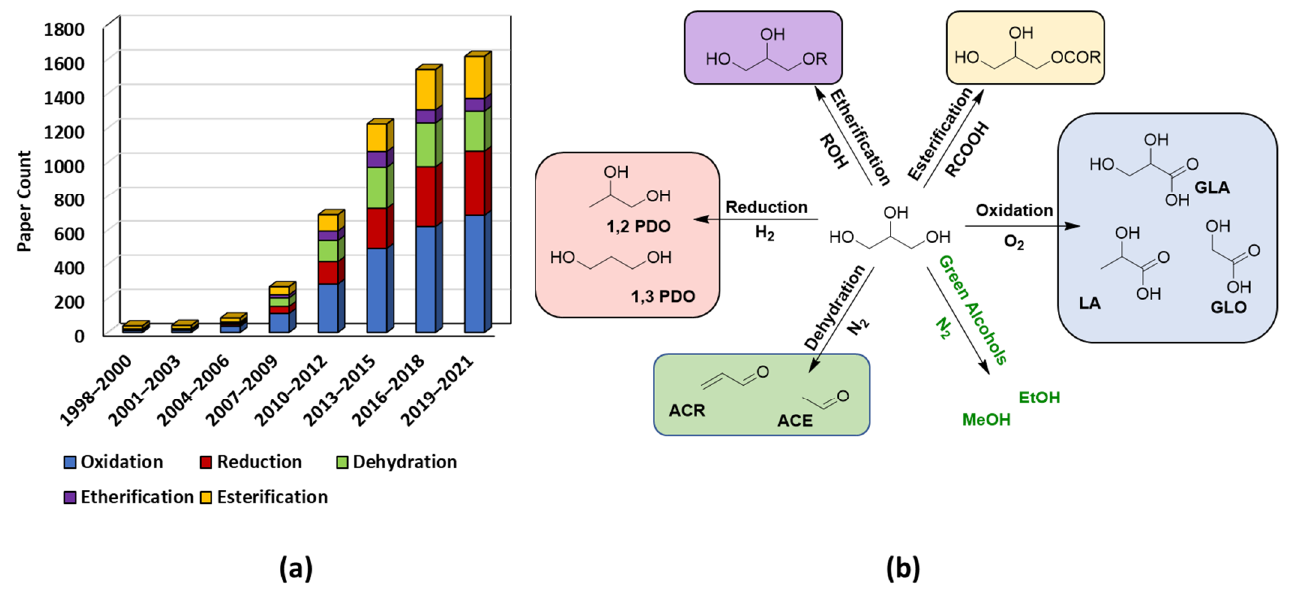
Figure 1. Evolution of research into catalysed glycerol valorization. ( a ) The number of papers published on catalytic glycerol valorisation since 1998; data sets collated every three years. Paper count acquired through web of knowledge search, where ‘glycerol’ and ‘catalyst’ were entered as topic search items, along with ‘oxidation’ (blue), ‘reduction’ (red), ‘dehydration’ (green), ‘etherification’ (purple) and ‘esterification’ (yellow). ( b ) schematic representation of each of the valorisation processes, typical reagents and key products. KEY: LA (lactic acid); GLA (glyceric acid); GLO (glycolic acid); PDO (propanediol); ACR (acrolein); ACE (acetonitrile).